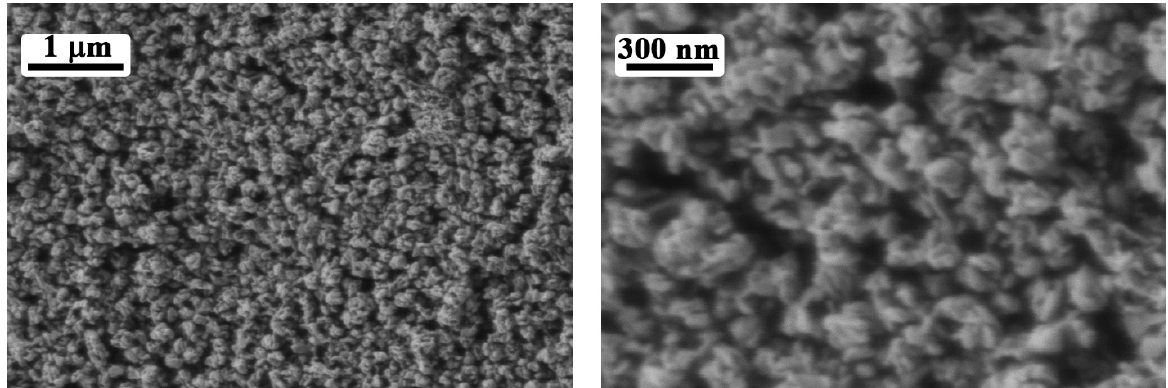
Figure 5. Microstructure for the printed V 2 O 5 film (according to SEM).